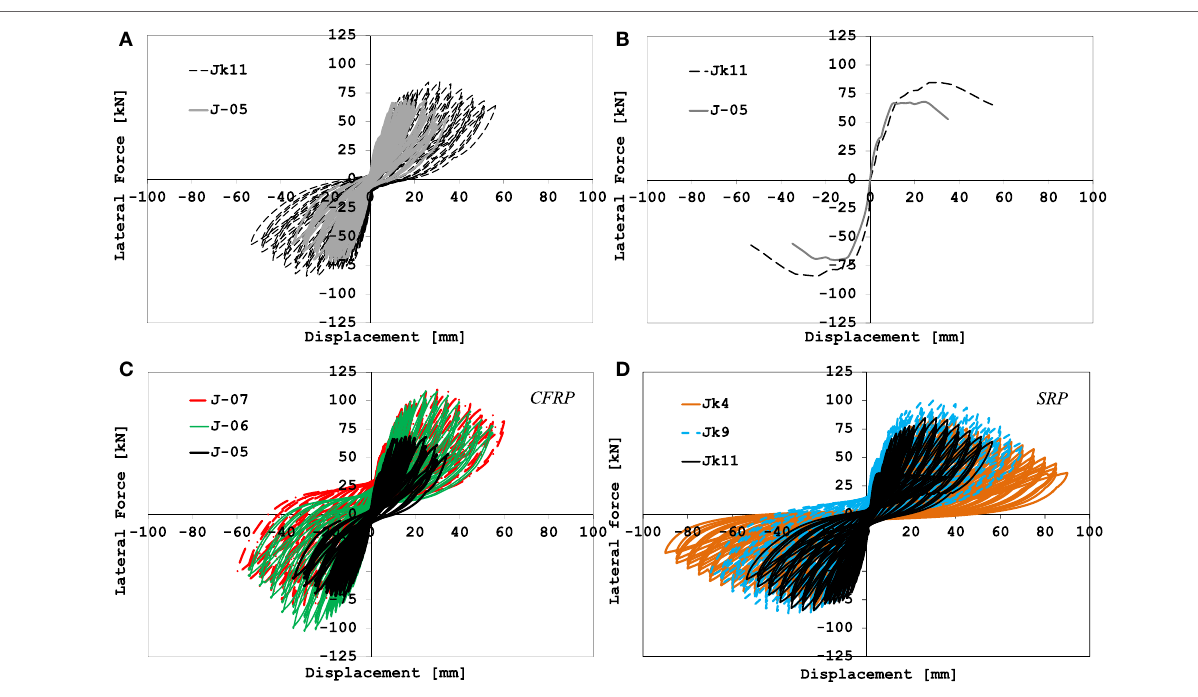
campaign, i.e., “J-05,” unstrengthened; “J-06” and “J-07” strength- ened according to the layouts of Figures 4A,B , respectively, which only differ for the presence/absence of steel profiles at the column corners. The cyclic curves shown in Figure 9D , instead,